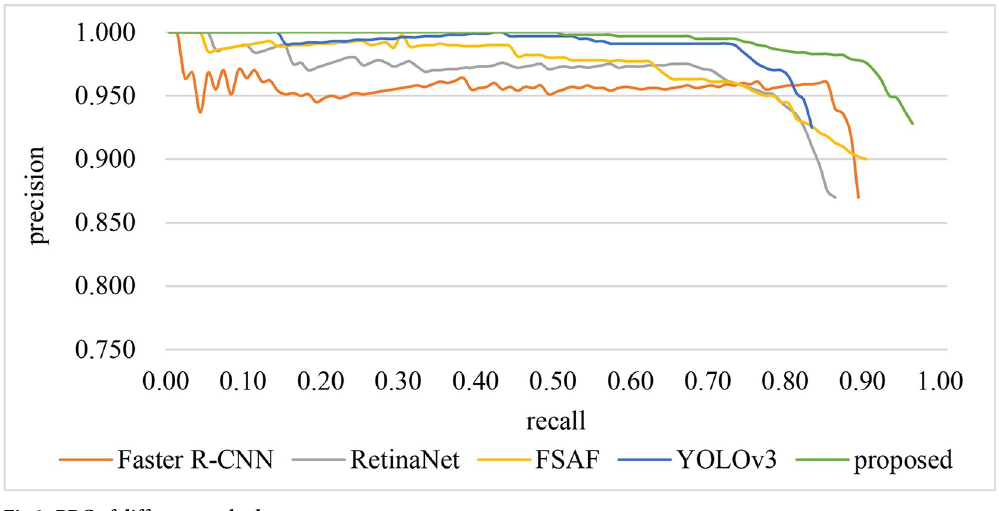
Fig 9. PRC of different methods.